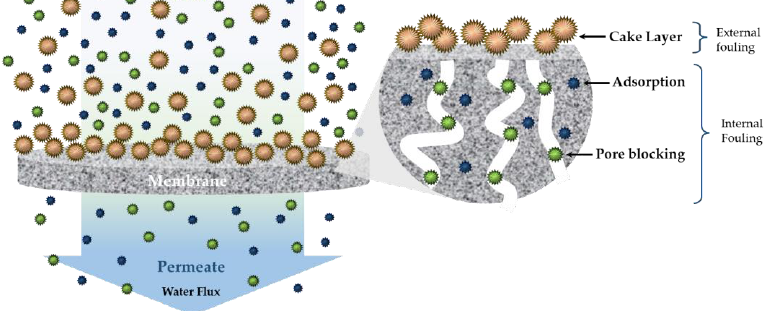
Figure 3. Schematization of different types of membrane fouling.